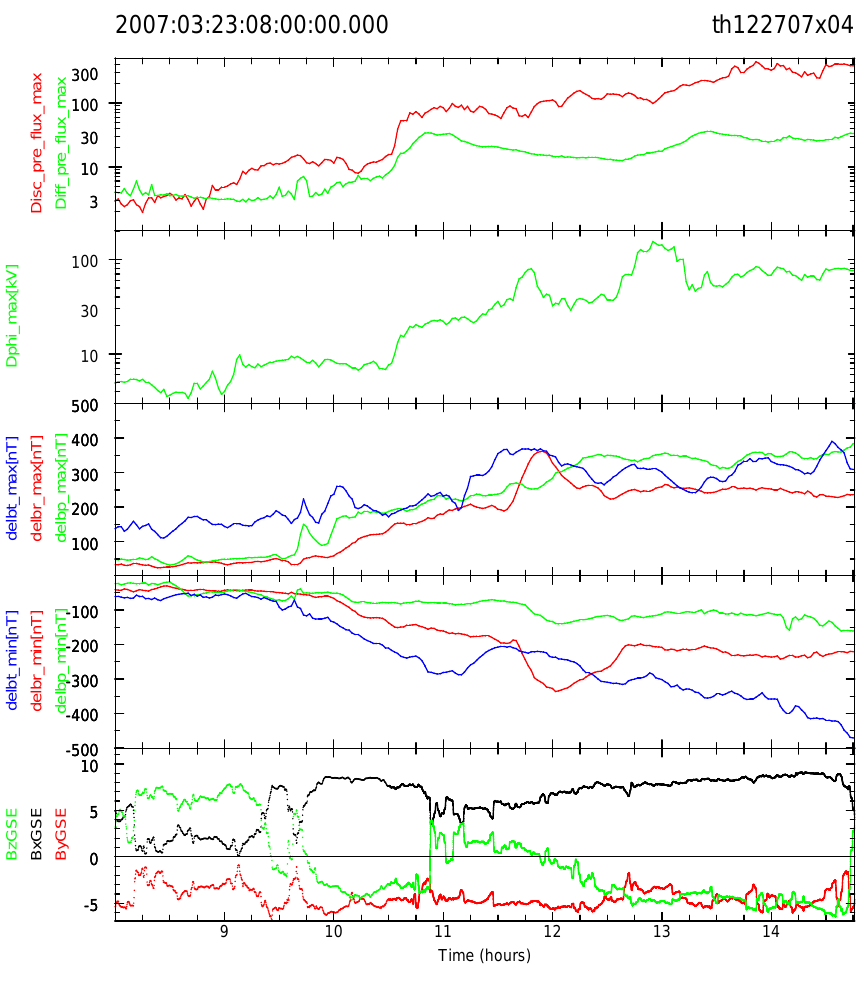
Fig. 1. Time series of representive ionosphere and solar wind conditions during 08:00UT ∼ 14:45UT from the simulation: Discrete and diffuse auroral electron precipitation energy flux [mW / m 2 ] (first panel); maximum Knight potential (second panel); maximum (third panel) and minimum (fourth panel) ground magnetic perturbations; magnetic field at upper stream location (16,0,0) of bow shock (fifth panel).